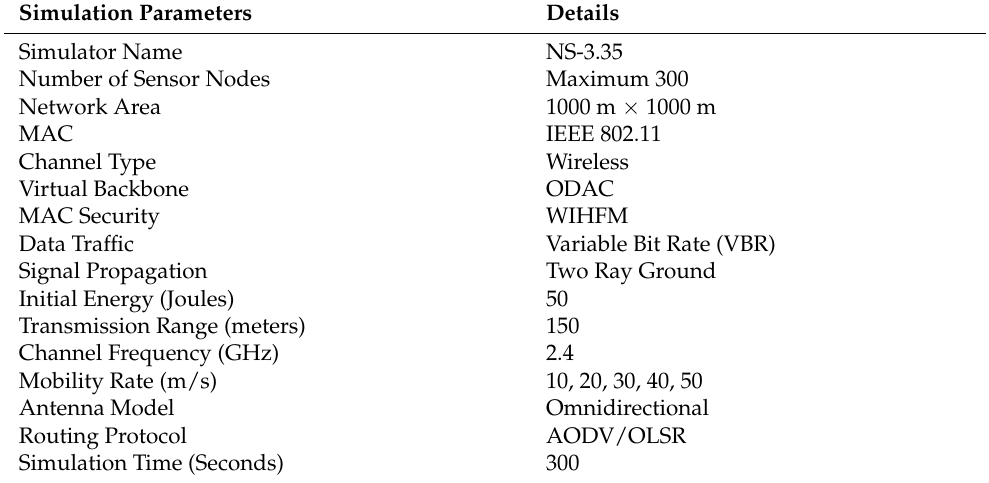
Table 1. Simulation